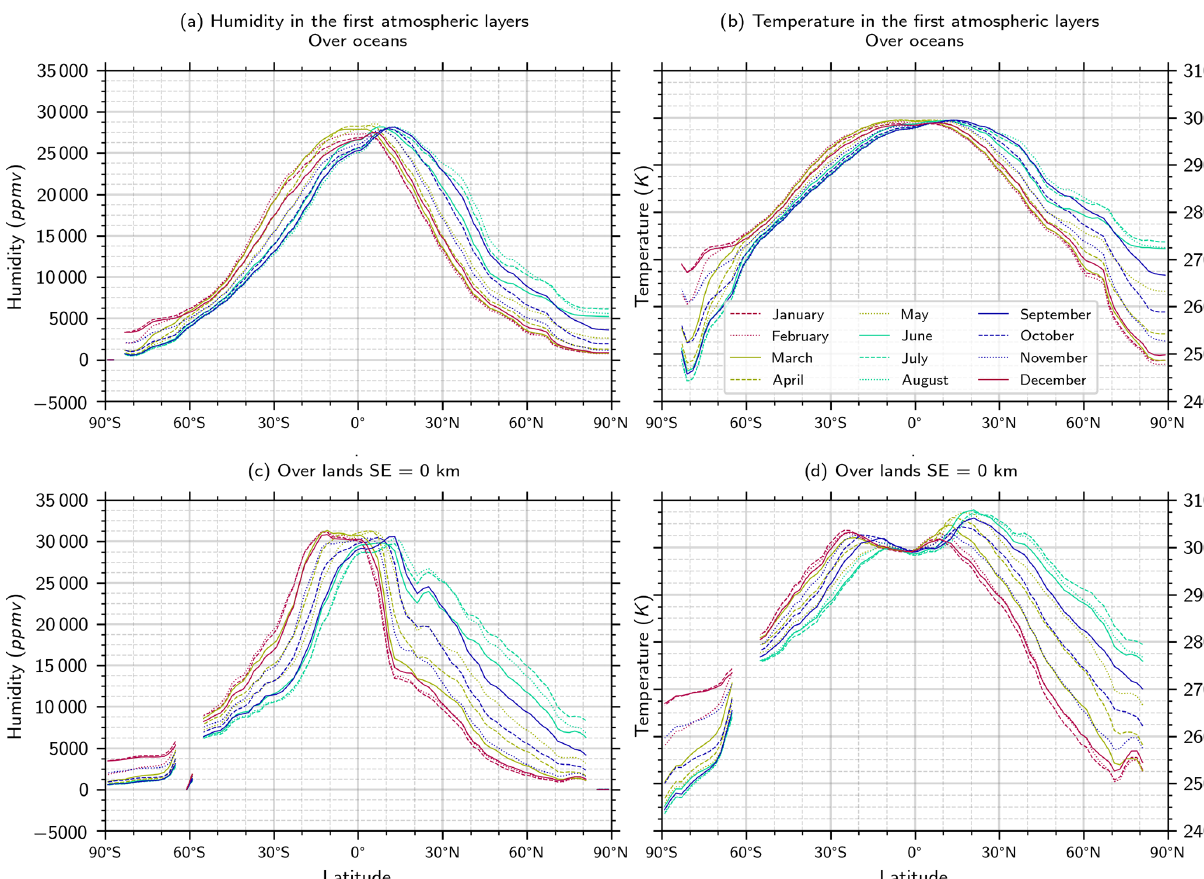
Figure A3. Seasonal and zonal variations of the temperature and humidity in the near-surface atmospheric layer ( Z < 1km) from ERA-